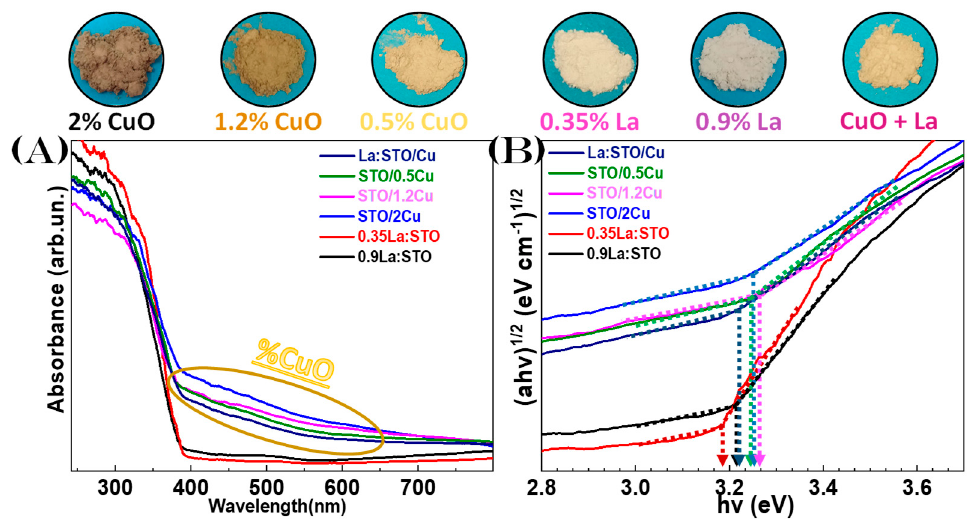
Figure 5. ( A ) DRS-UV-Vis data for the SrTiO 3 particles. ( B ) Tauc-Plots with the dotted arrows show the calculated bandgap. Side-photos: The powder nanoparticles showcase the color shift.